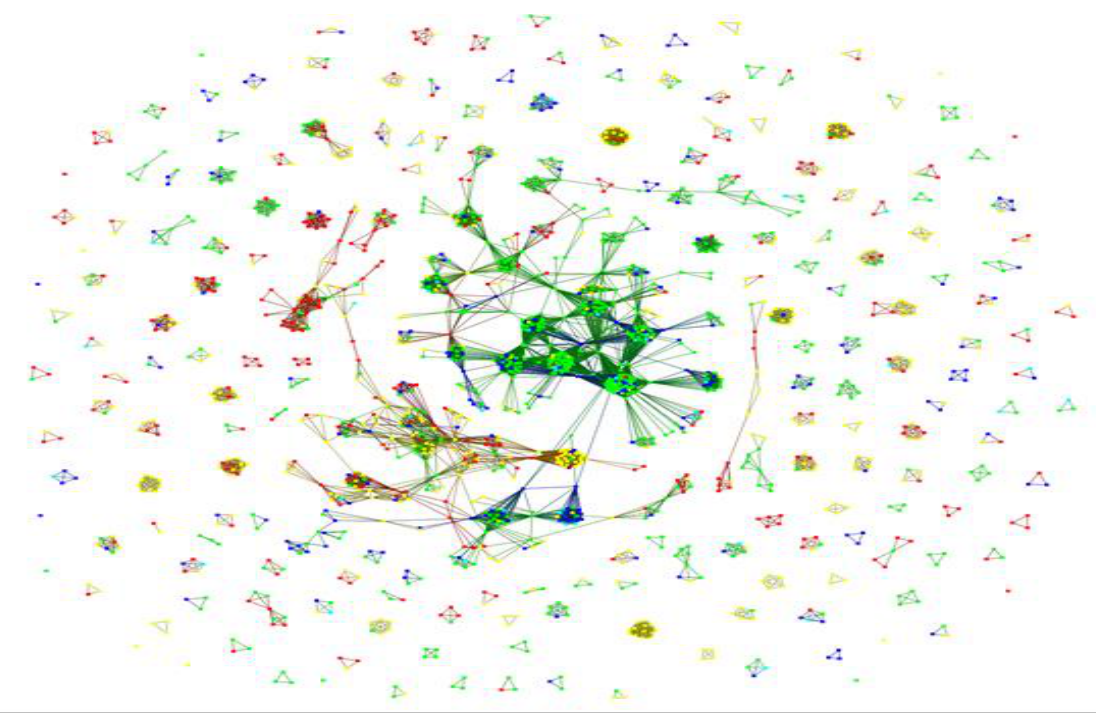
Figure 2. COVID-19 vaccine misinformation URL co-sharing network. Green dots represent misinformation spreader, yellow dots represent fact checkers with repetitions, and red dots represent fact checkers without repetitions. Links represent URL co-sharing relationships among